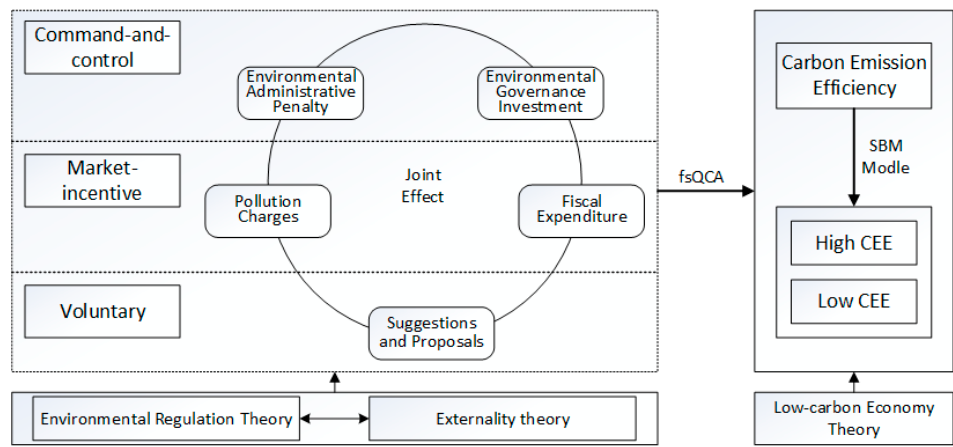
Figure 1. The analytical framework of environmental regulation